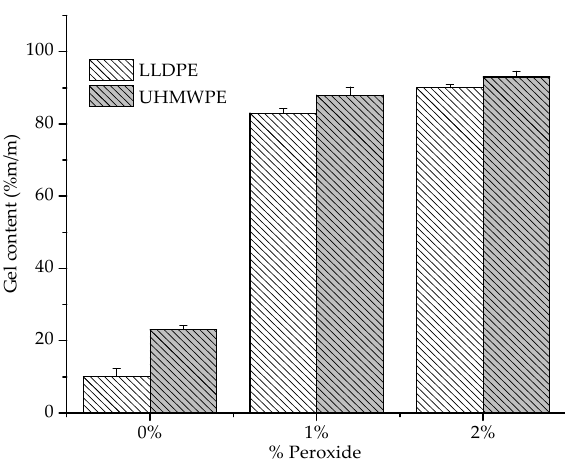
Figure 9. Gel contents of LLDPE and UHMW PE with 1% and 2% peroxide. The thermal properties of LLDPE and UHMWPE were determined with differential scanning calorimetry (DSC), where the melting enthalpy of the crystalline phase ( ∆ H m ), Some other thermomechanical factors can be considered for the degree of peroxide melting temperature (T m ) and the degree of crystallinity (X c ) were measured. incorporation in polyethylenes. One is that during the mixing process, the peroxide and or crystallization events occurred for LLDPE and UHMWPE with the addition of 1% and 2% peroxide, respectively.